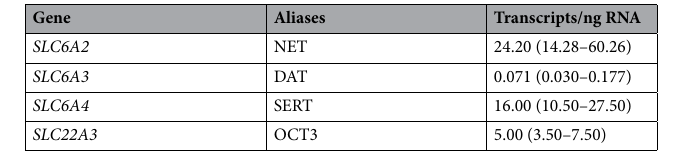
Table 1. Absolute quantification of monoamine transporter gene transcripts in the human term placenta (gestational age at delivery: 39–40). Target genes were amplified to the endpoint in a duplex ddPCR system, yielding high-precision quantification. The final output is reported as target transcripts/ng RNA. The results are shown as median with interquartile range, n ≥ 12.